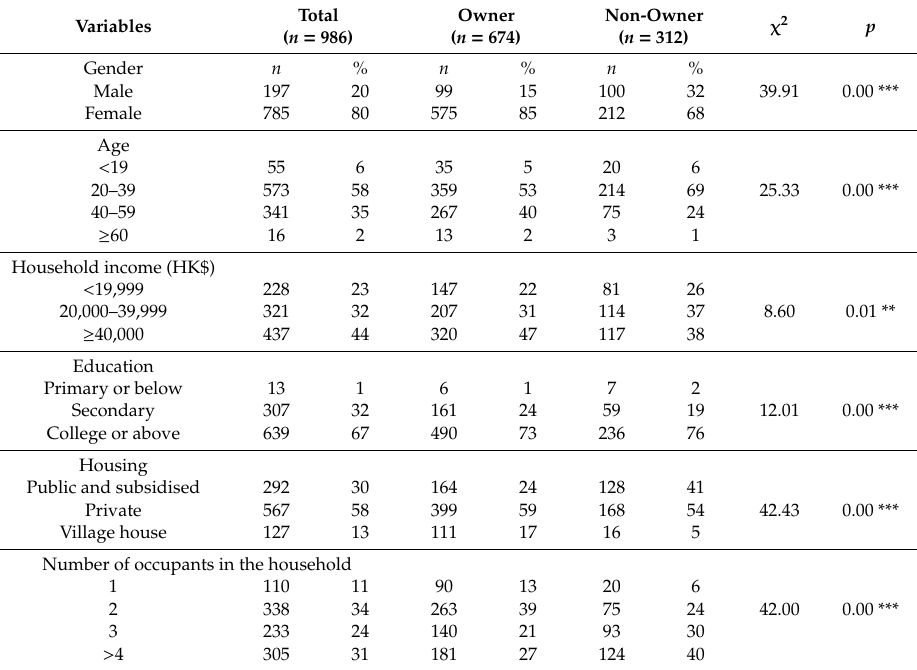
Table 1. Socio-demographic characteristics of owners and non-owners.